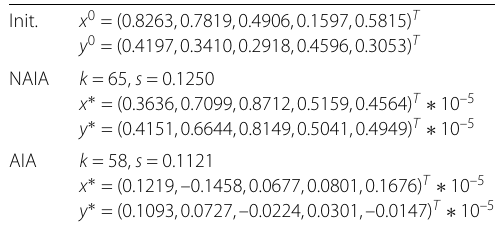
Table 1 The numerical results of Example 4.1